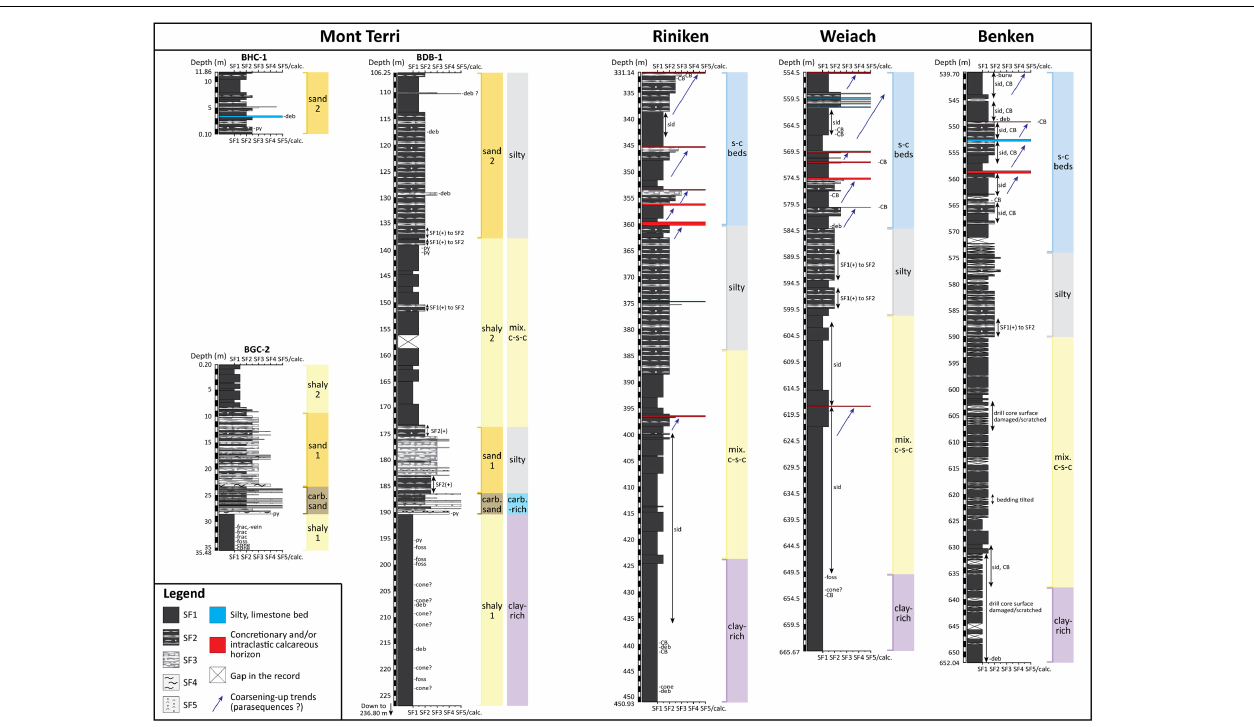
FIGURE 5 | Overview of the Opalinus Clay succession in different locations (Mont Terri, Riniken, Weiach and Benken). Drillings crossed bedding planes at an angle of about 90 ◦ . The lithologs follow the subfacies classification scheme presented herein. Sub-units at Mont Terri refer to the facies classification as used within the Mont Terri Project (Bossart and Thury, 2008; Hostettler et al., 2017). shaly 1, lower shaly facies; carb. sand, carbonate-rich sandy facies; sand 1, lower sandy facies; shaly 2, upper shaly facies; sand 2, upper sandy facies. Sub-units in northern Switzerland refer to the refined sub-units proposed by Mazurek and Aschwanden (2020). clay-rich, «clay-rich sub-unit»; carb.-rich, «carbonate-rich silty sub-unit»; mix. c-s-c, «mixed clay-silt-carbonate sub-unit»; silty, «upper silty sub-unit»; s-c beds, «sub-unit with silty calcareous beds»; calc. (label), calcareous lithology (limestone). Possible parasequences (“Dachbank” cycles; Wetzel and Allia, 2003) are outlined by blue arrows.